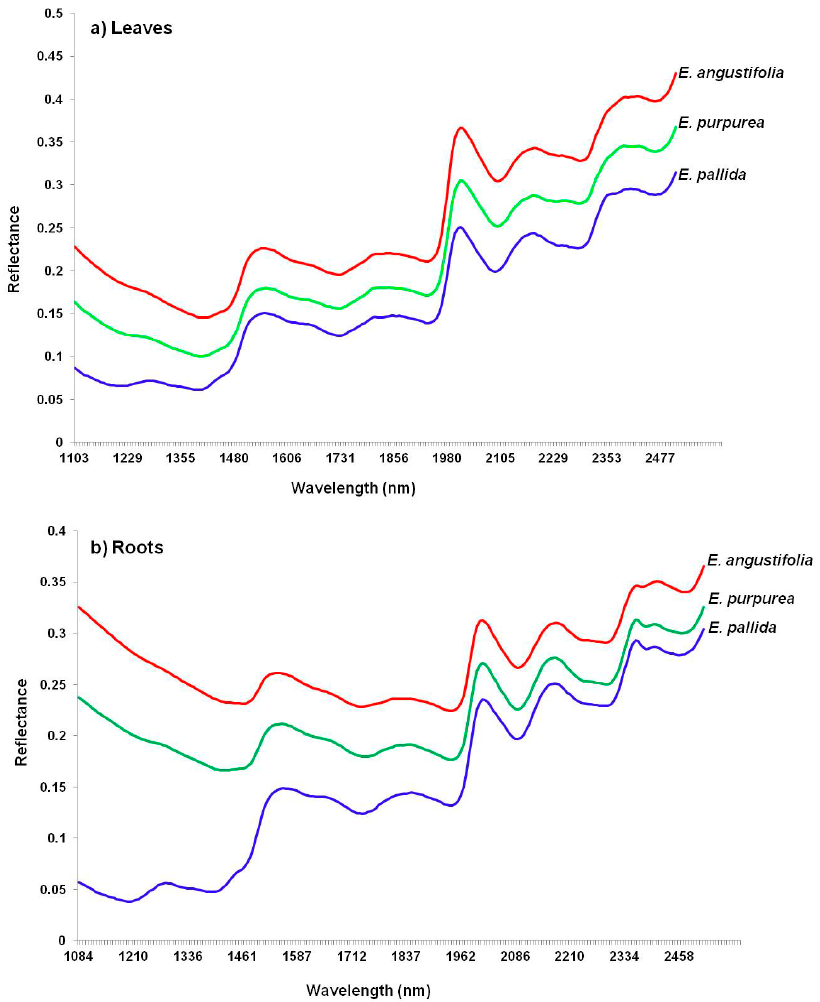
Figure 3. NIR imaging spectra of ( a ) Echinacea leaves and ( b ) roots showing similar spectral patterns of the three